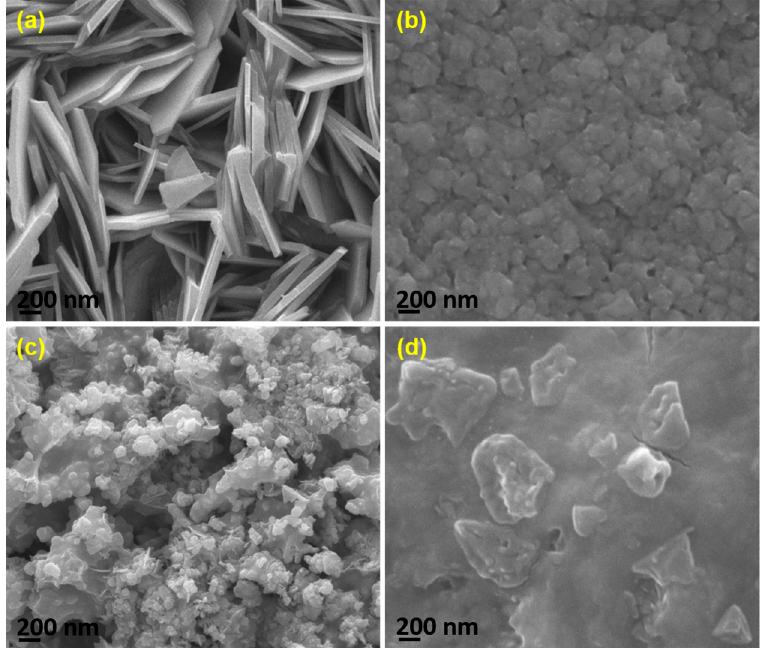
Figure 3. SEM Micrographs of electrosynthesized composite thin films ( a ) chitosan-ZnO; ( b ) chitosan- Zn 0.6 Cu 0.4 O; ( c ) chitosan-Zn 0.3 Cu 0.7 O; and ( d ) chitosan-CuO. ( b ) chitosan-Zn 0.6 Cu 0.4 O; ( c ) chitosan-Zn 0.3 Cu 0.7 O; and ( d )